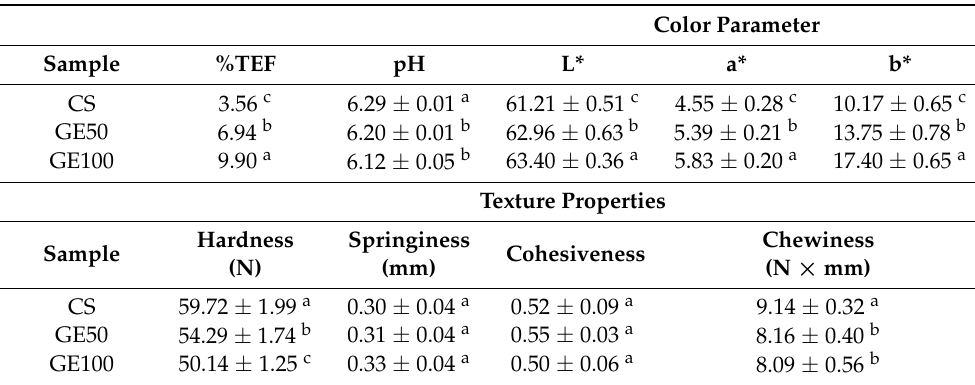
Table 3. Physic-chemical properties of Frankfurt-type sausage formulates replacing pork backfat with gelled emulsion elaborated with peanut flour and flaxseed